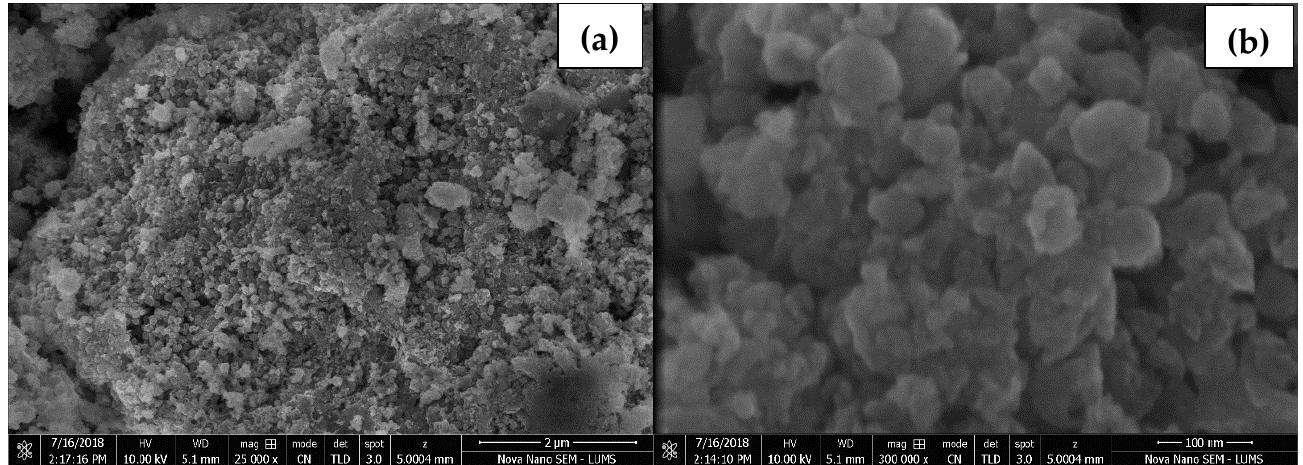
Figure 2. ( a ) Low and ( b ) high magnification SEM micrographs of CuO NPs.